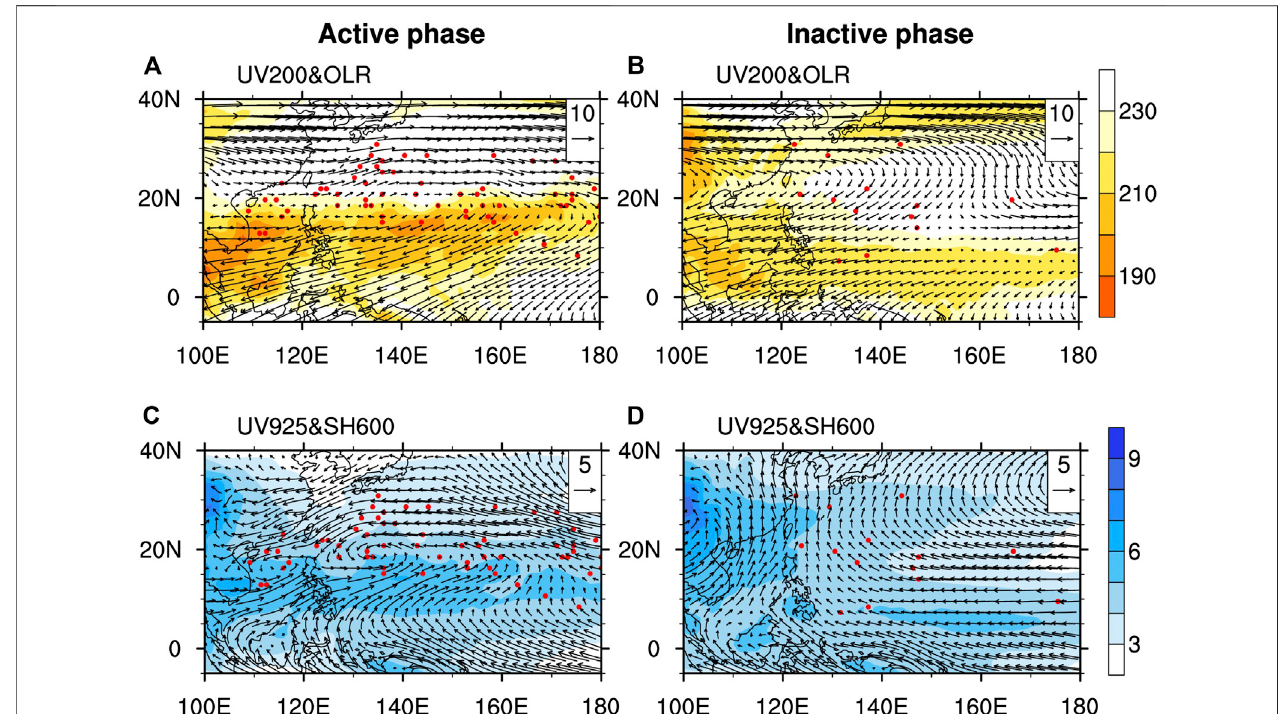
FIGURE8| Composite fi eldsoftypical eventsintheactive andinactivephases. (A and B) 200 hPawind (m s − 1 )andOLR(Wm − 2 ). (C and D) 925 hPawind (m s − 1 ) and 600 hPa speci fi c humidity (10 – 3 kg kg − 1 ). The red solid marks denote the genesis location of TCs.